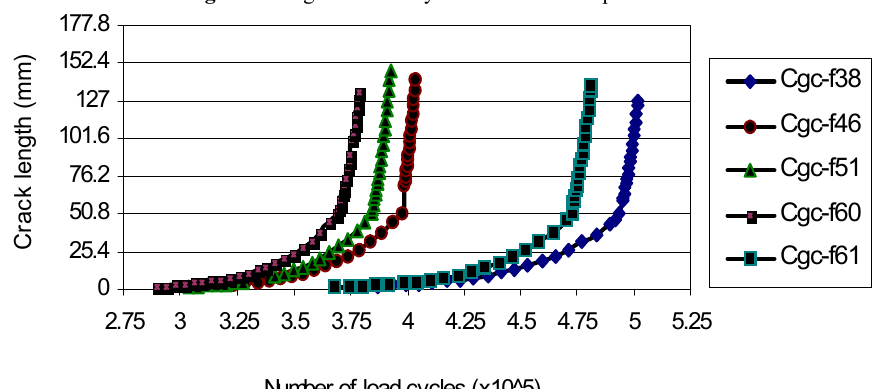
Fig 2. Crack growth history data of corroded specimens